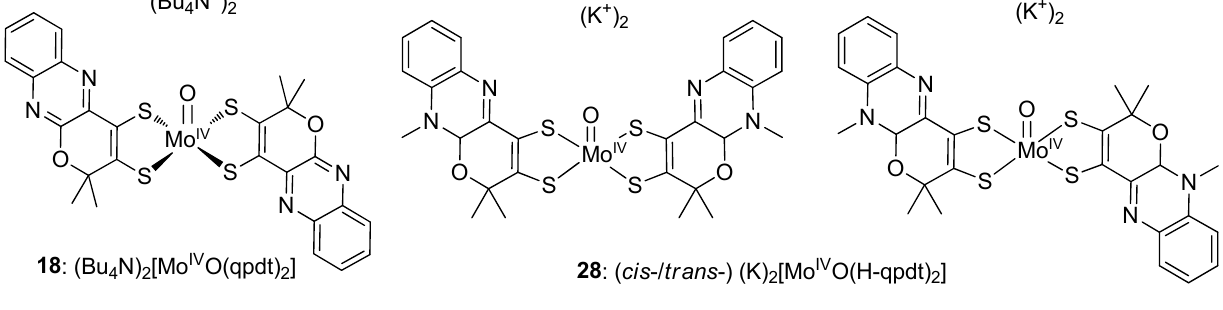
Scheme 7. Synthesis of the protected ligand 17 and structure of ligand qpdt.